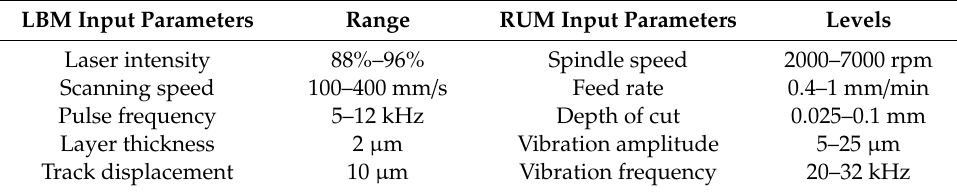
Table 3. LBM and RUM parameters and their respective levels.